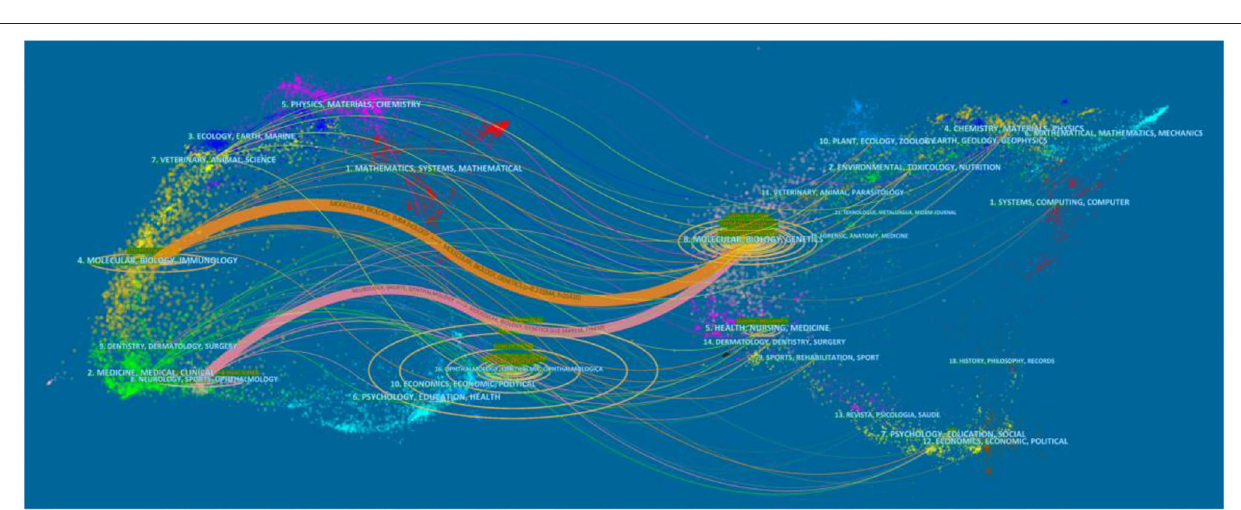
lenses,” #3 “a1 mutation,” #4 “foxe3 mutation,” #5 “cell adhesion gene pvrl3,” #6 “nid1 gene.” This paper described the knowledge base of cataract gene research according to different